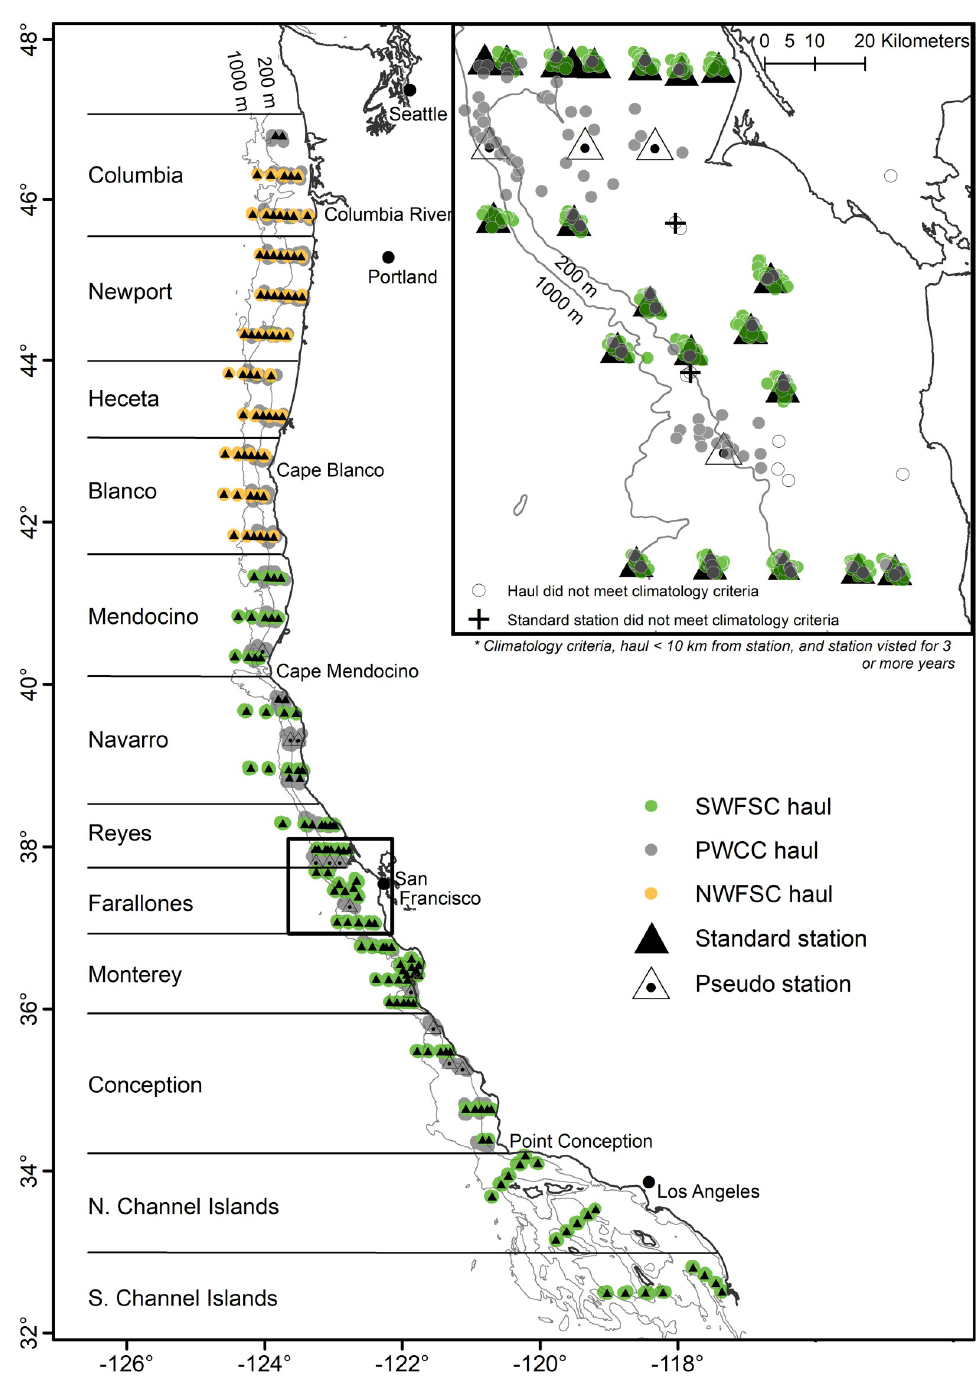
Fig 1. Station map, including fixed stations, pseudo-stations, regions, and major biogeographic